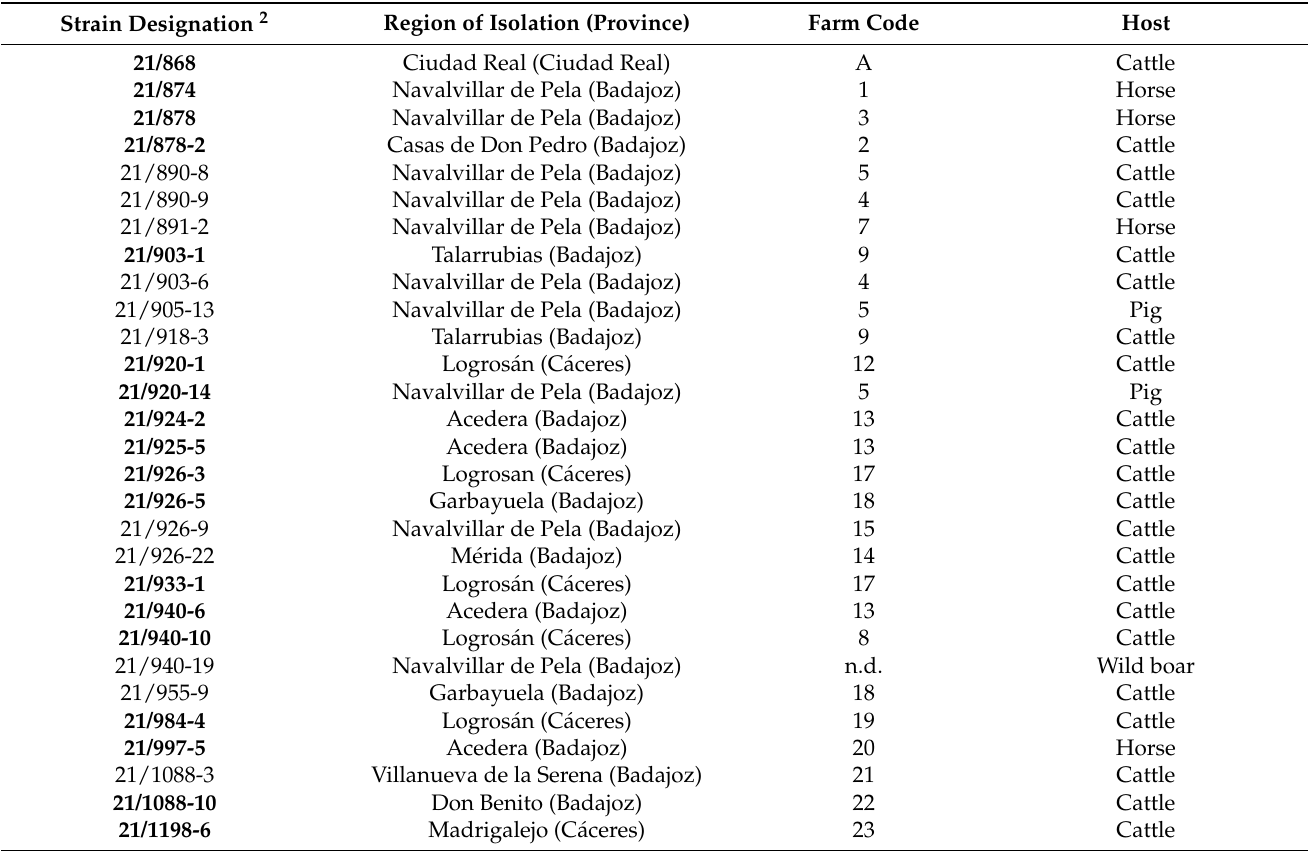
Table 1. B. anthracis strains isolated from outbreaks in Spain in 2021 1